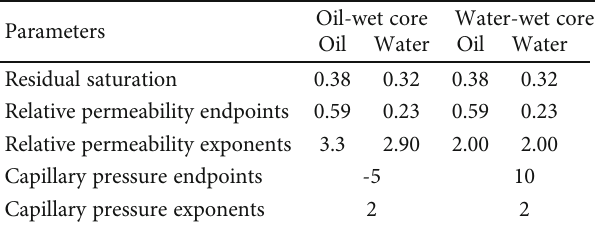
Figure 1: History matching results of the spontaneous imbibition experiment for an oil-wet tight Table 1: Characteristic parameters of relative permeability curves.